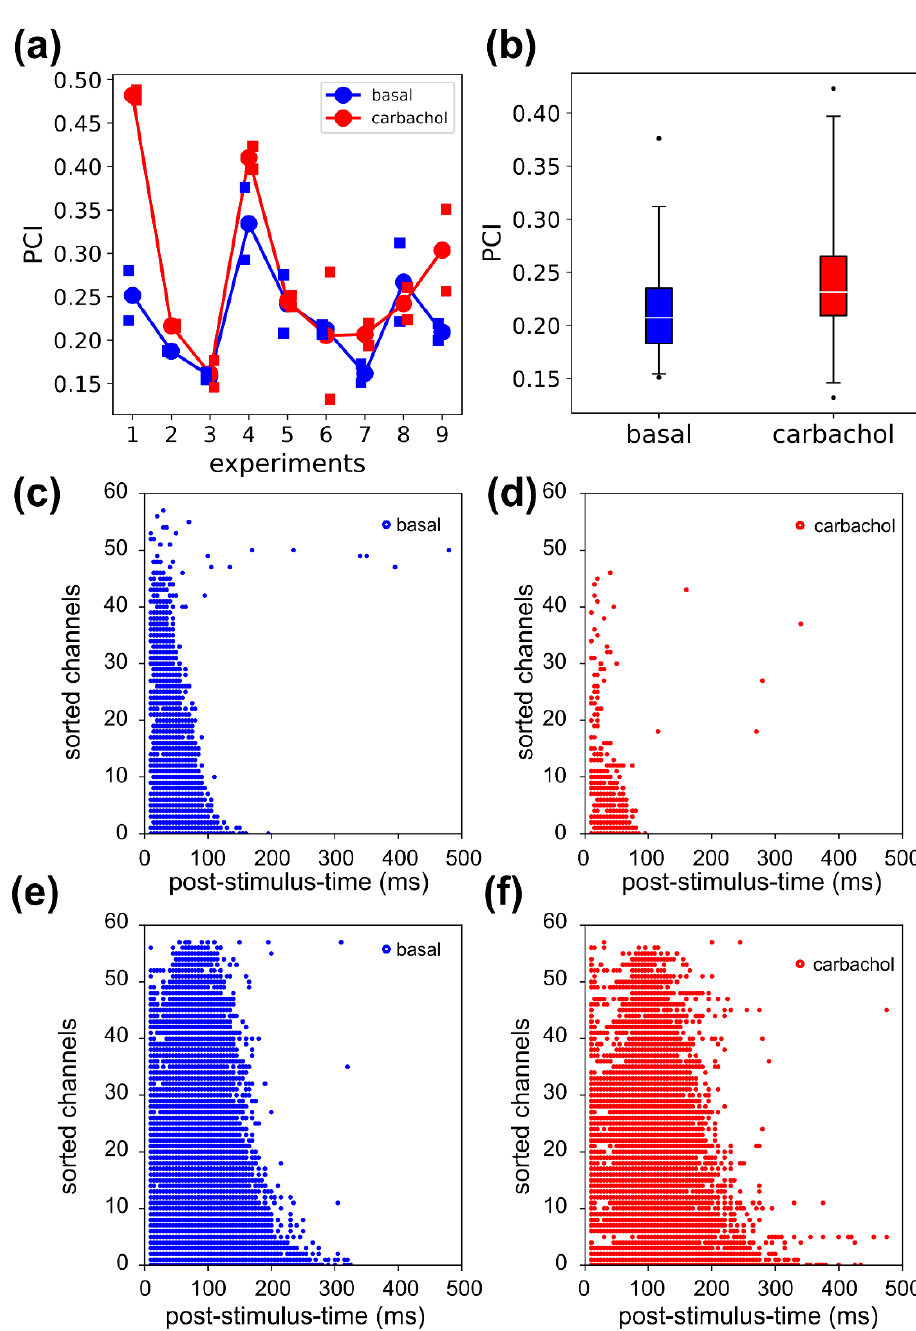
Figure 7. Complexity measure of evoked activity. ( a ) The curves connect the mean PCI obtained by averaging across the PCI values of the two stimuli for each experiment. The squares are relative to the PCI values of the single stimuli. ( b ) The perturbational complexity index (PCI) increases significantly in carbachol by 22% ( p = 0.023, two-way ANOVA with factor drug treatment). ( c , d ) The binary matrix of significant sources relative to exp1, in basal ( c ) and CCh ( d ) conditions. The CCh administration caused a decrease in source entropy (0.55 basal, 0.21 CCh). ( e , f ) In exp9, the binary matrices of significant sources have comparable source entropies across conditions (0.92 basal, 0.93 CCh). The dots in the panels c-f correspond to the significant spatial-temporal activations.